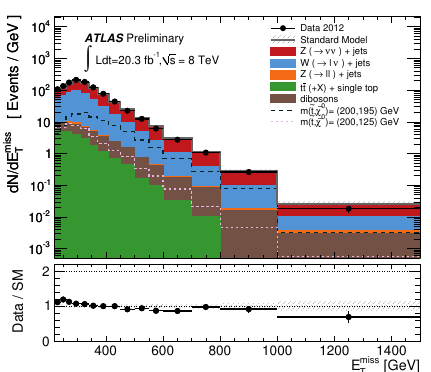
distribution for the T